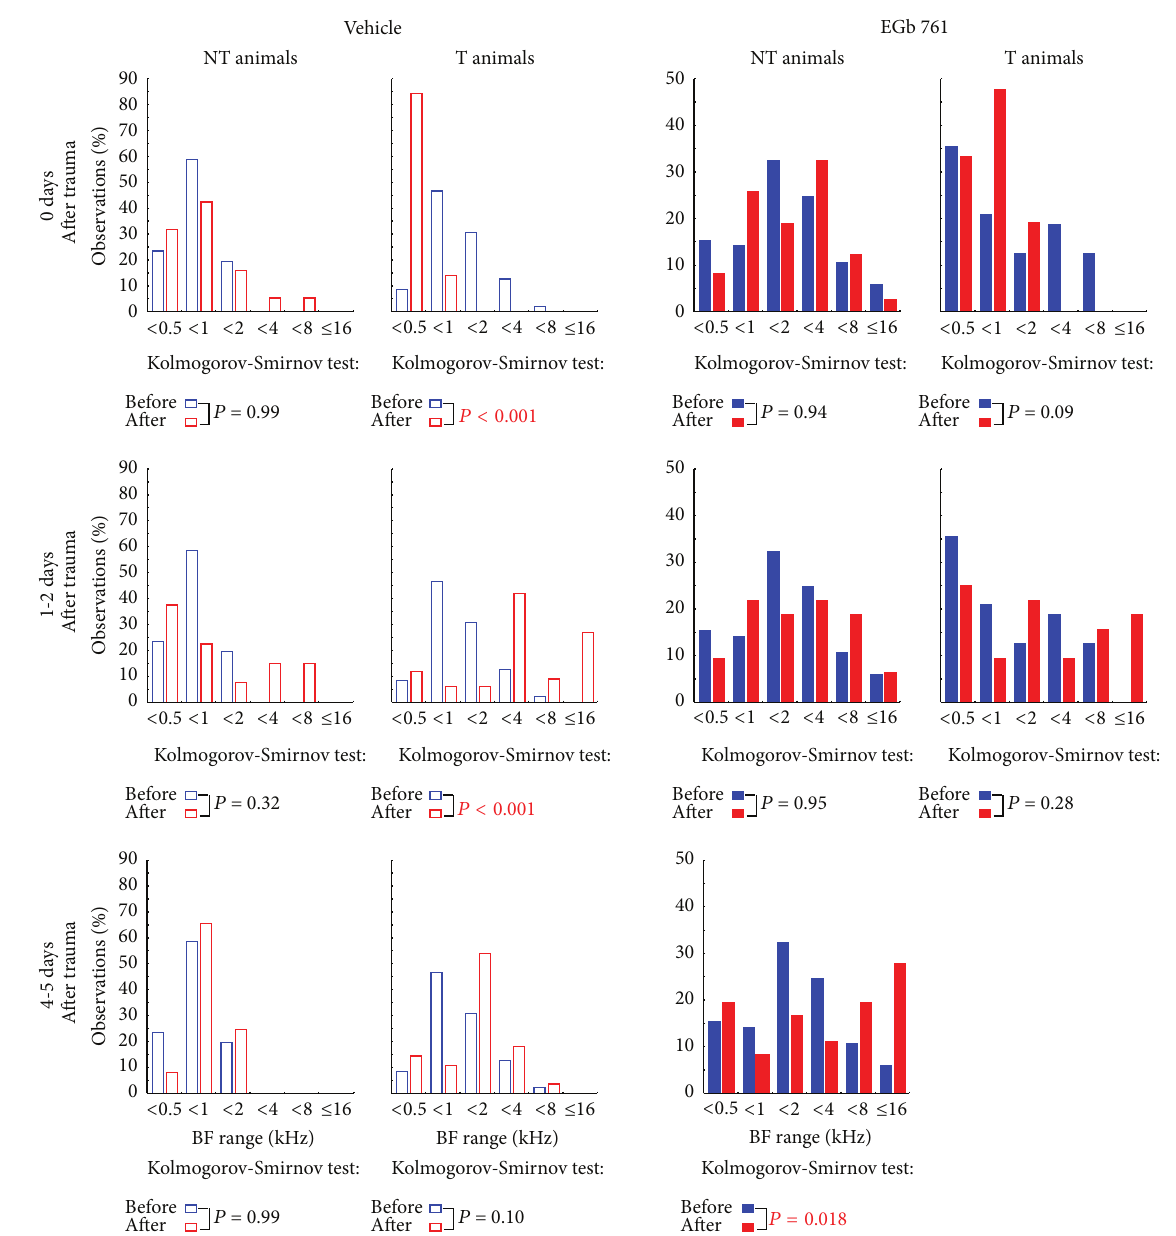
Figure 9: Changes in BF frequency distributions over time. Shown are the comparisons of the frequency distributions of BF (observations in %) binned in one octave step of vehicle treated animals (left two columns) and EGb 761-treated animals (right two columns). Treated and untreated animal groups are further subgrouped into NT (first and third column) and T animals (second and fourth column) before the trauma (blue) with the data obtained during 3 different time points windows after trauma (red), from top to bottom: day of trauma, 1 to 2 days after trauma, and 4 to 5 days after trauma. The distributions are tested by Kolmogorov-Smirnov tests corrected for multiple comparisons. Note that we were not able to record from the single animal in the EGb 761 tinnitus group at days 4 to